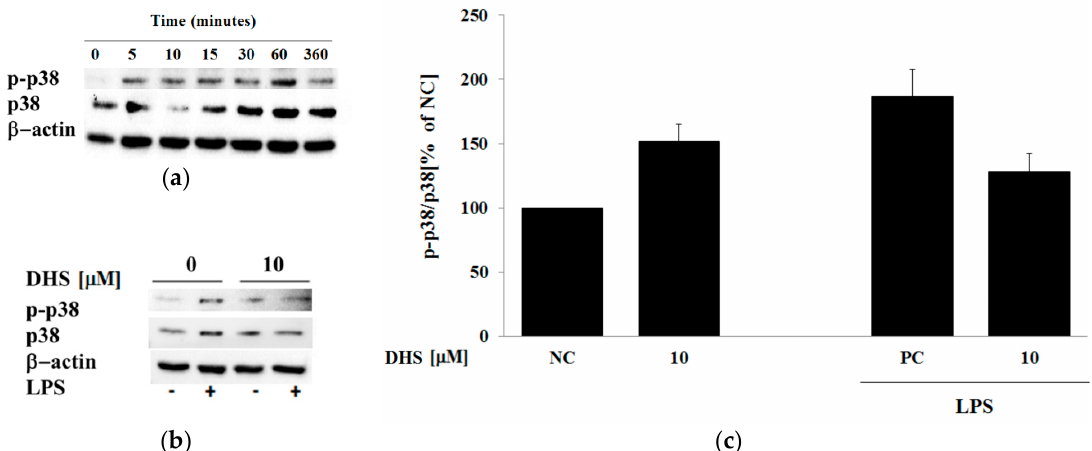
Figure A1. Western blot analysis of MAPK/p38 activation stimulated by LPS. ( a ) Time course measurement; NHDF were stimulated or unstimulated with 10 µ g mL − 1 of LPS for 5, 10, 15, 30, 60 or 360 min. Beta-actin served as a loading control. Representative blot image. ( b ) The evaluation of the MAPK/p38 activation using the phospho/total protein ratio after the exposure to 10 µ M DHS for 10 min with or without LPS-cotreatment. Beta-actin served as a loading control. Representative blot image. ( c ) Schematic representation of p38 phosphorylation after the exposure to 10 µ M DHS for 10 min with or without LPS-cotreatment. Results are expressed as mean percentage relative to NC ± SEM ( n = 2). NC: negative control (0.1% vehicle DMSO in serum-free culture medium), PC: positive control (10 min of LPS stimulation with 0.1% vehicle DMSO in serum-free culture medium). Quantification was performed by densitometric analysis of Western blot bands.